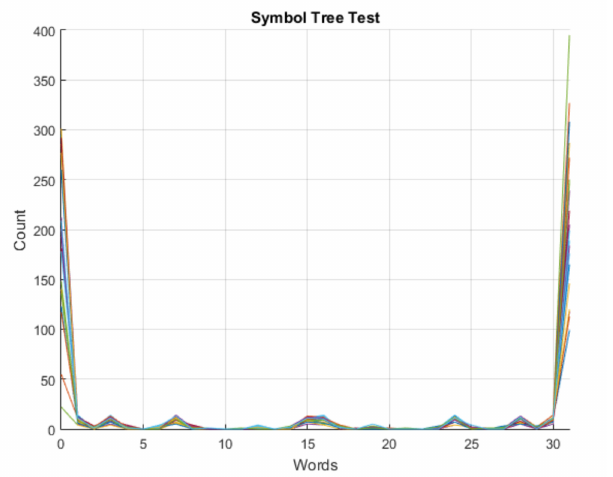
Figure 1. Result of the symbol tree test for the sound signal under